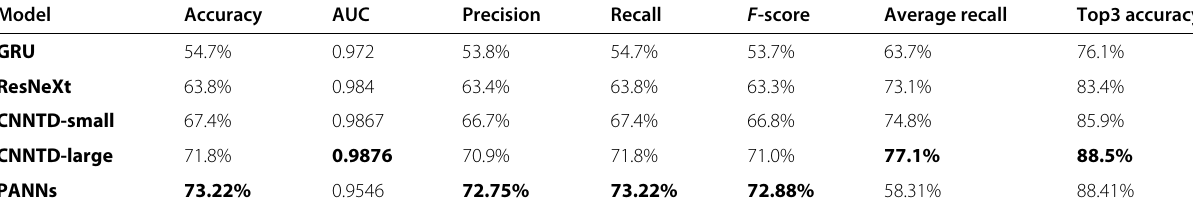
Table 3 Performance comparison of various audio classification methods on human labeled test set